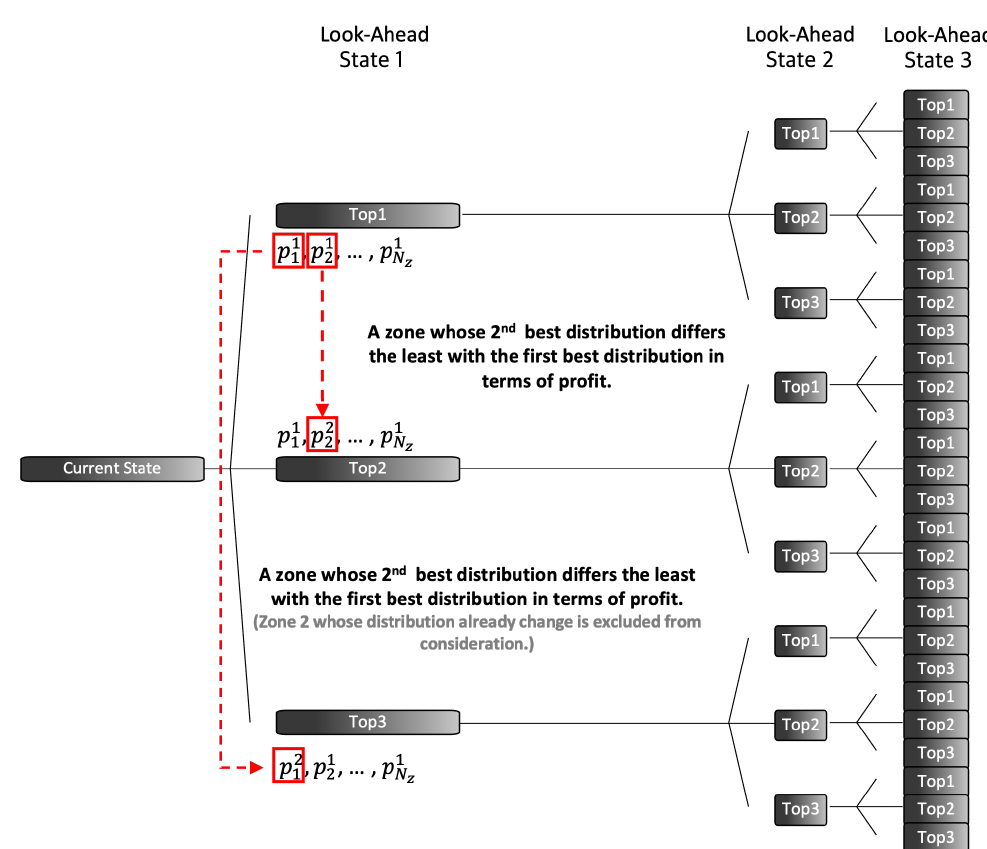
Figure 6. In every look-ahead state, M-Greedy chooses the top-k distributions that yield the highest revenue and profit. In this figure, each block represents a top-k case after simulating all cases in the preceding state. Then, the platform looks ahead D time steps in the future. As a result, M-Greedy chooses the best case among k D cases once the computation is finished on the last look-ahead